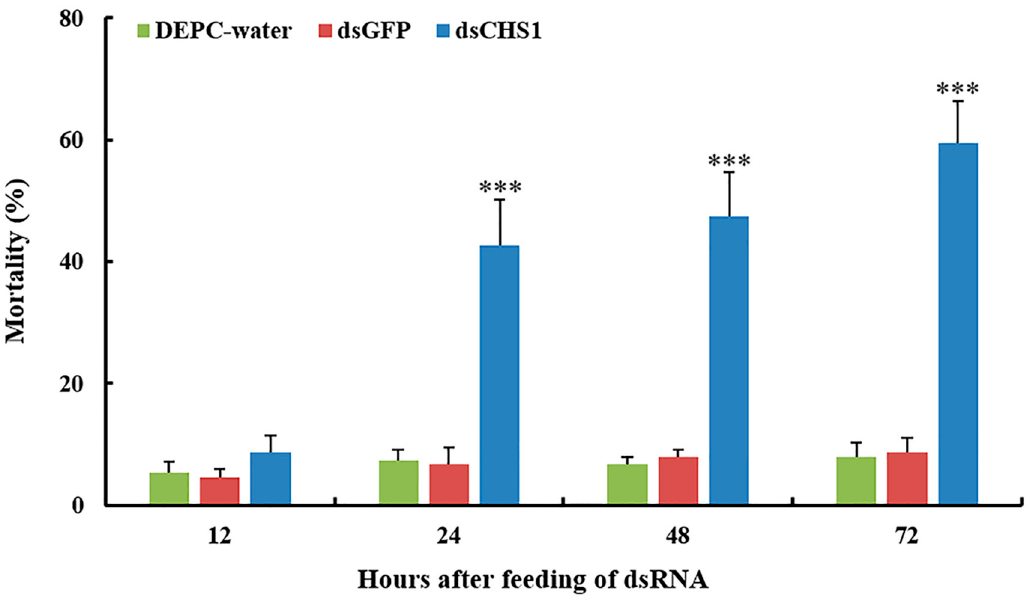
Figure 3. Mortality rates (%) of A. gossypii fed with artificial diet containing DEPC-water, dsGFP, and ds CHS1 at third instar nymphal stage over time. The values are presented as the mean (±SE) of three replications (50 insects were used per replicate). Treatments were compared using one-way ANOVA (Tukey’s HSD test, p < 0.05). *** represents p < 0.001.